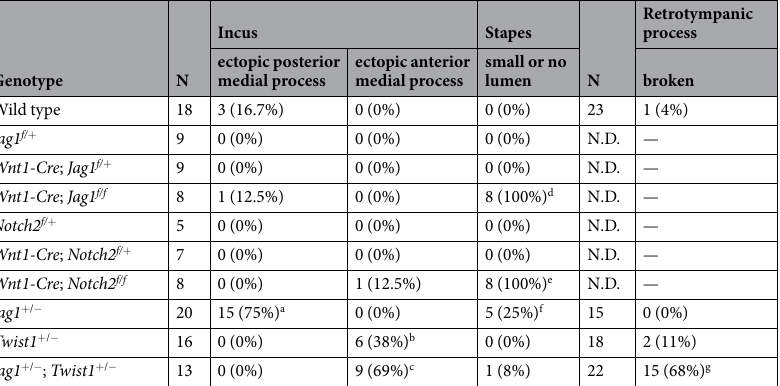
Table 1. Summary of incus and stapes defects in mice deficient for Jag1 , Notch2 , and Twist1 . For statistical analysis, we performed a multi-group comparison using a Fisher Exact Test or Chi-Square Test, followed by post-hoc pair-wise comparisons. N.D. = not determined. a p < 0.005 vs wild type, Twist1 + / − , and Jag1 + / − ; Twist1 + / − . b p < 0.01 vs wild type and Jag1 + / − . c p < 0.025 vs Twist1 + / − . d p < 0.001 vs Jag1 f/ + and Wnt1 - Cre ; Jag1 f/ + . e p < 0.001 vs Notch2 f/ + and Wnt1 - Cre ; Notch2 f/ + . f p < 0.05 vs wild type. g p < 0.001 vs wild type, Jag1 + / − and Twist1 + / −